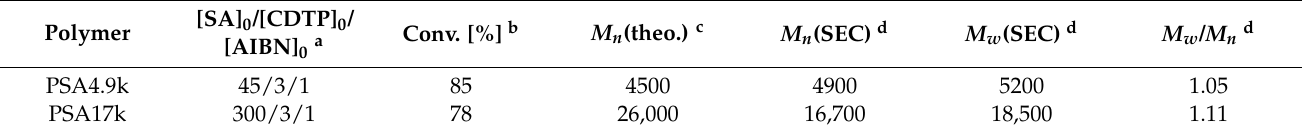
Table 1. RAFT polymerization of SA with CDTP as